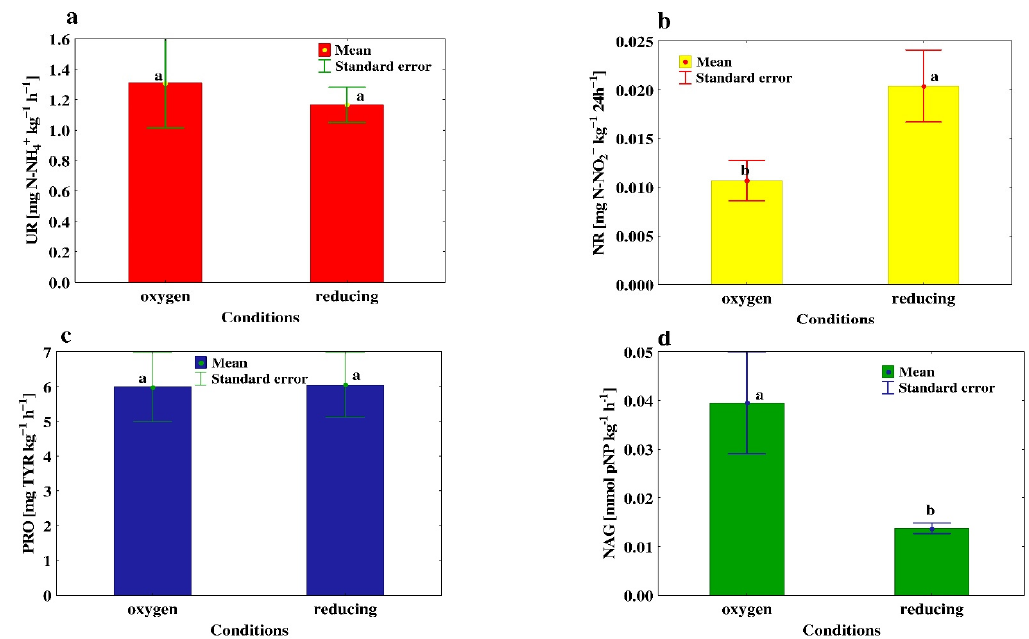
Figure 1. Effect of reducing conditions on the potential UR ( a ), NR ( b ), PRO ( c ), NAG activity ( d ), whereas oxygen conditions refer to three the deepest horizons in the profiles 1 and 3, while reducing conditions refer to three the deepest horizons in the profiles 2 and 4 (mean ± SE). Values in compared horizons followed by different small letters are statistically different at p < 0.05.